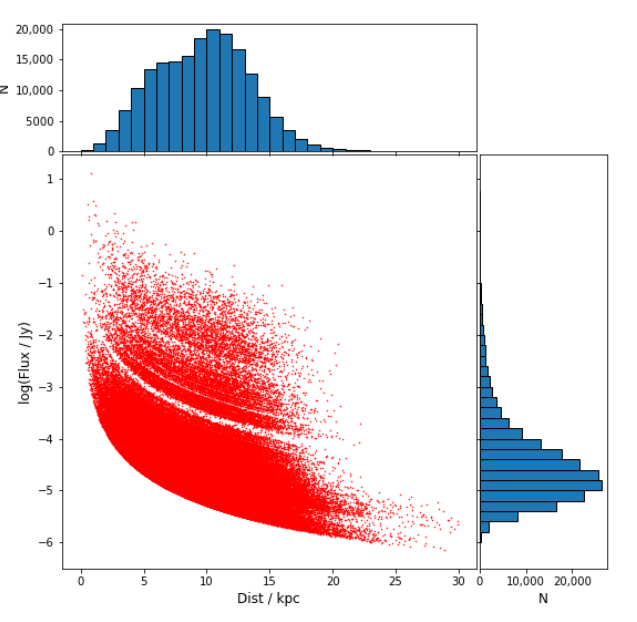
Figure 7. The distribution of distance and estimated fluxes of detectable UC HII regions. The upper panel is for the distance, while the right is for the flux. The middle panel shows how the flux varies with distance. The gaps are due to the stellar temperature gridding in the Besançon model, combined with a very steep temperature-luminosity relation for the most massive main sequence